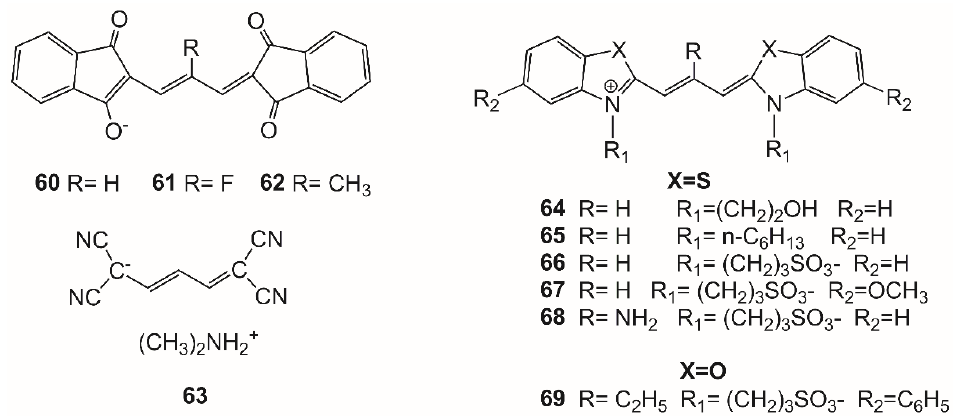
Figure 14. Structures of anionic oxonols 60 – 62 , tetracyanotrimethine dye 63 ; cationic ( 64, 65 ) and anionic trimethine cyanines ( 66 – 69 ).